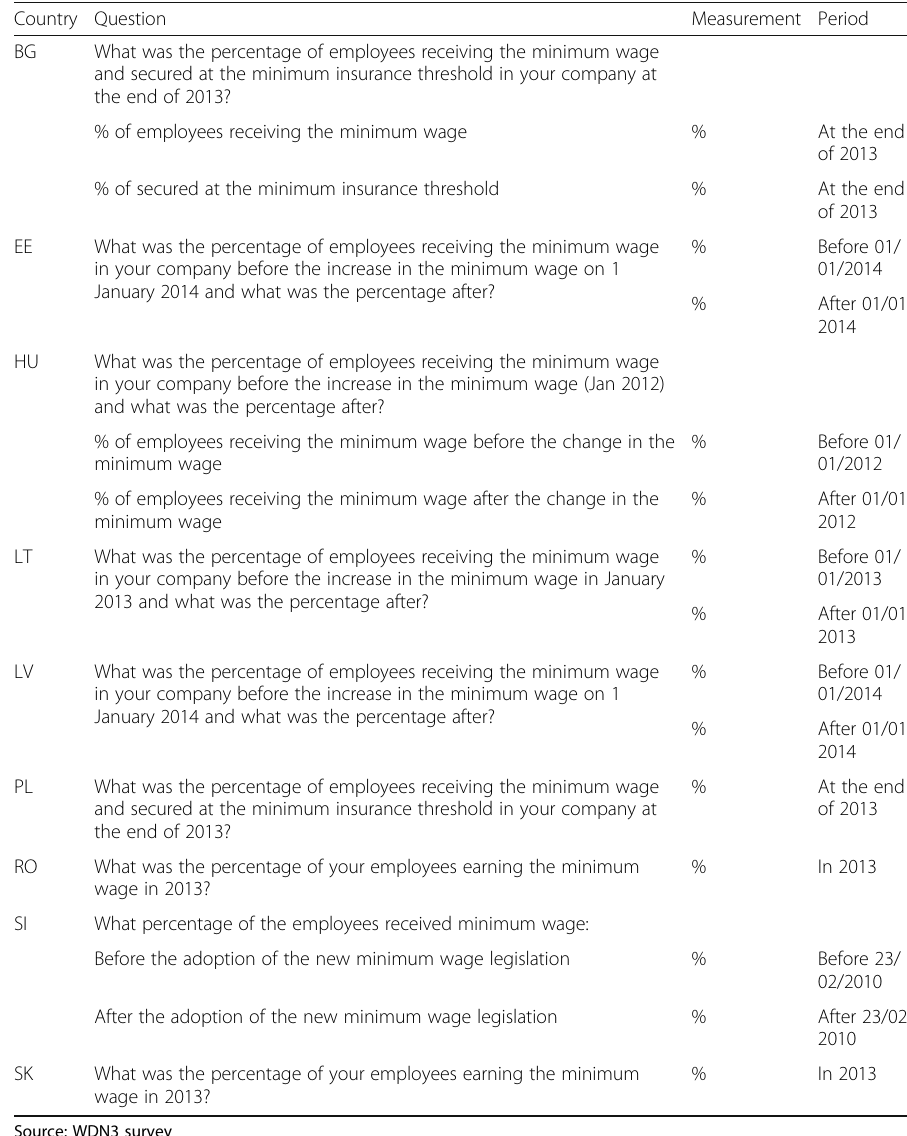
Table 7 Country specific questions: share of employees earning the minimum wage Country Question Measurement